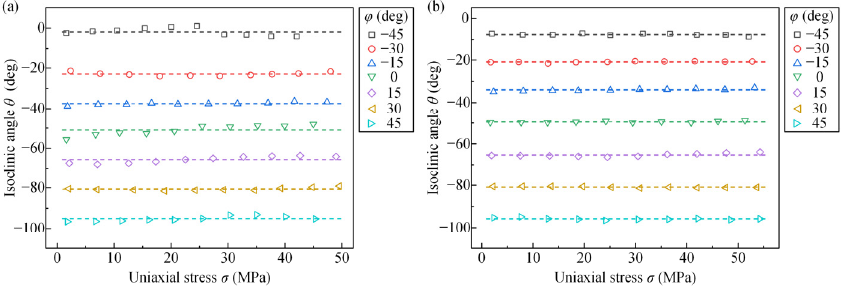
Figure 6. The relation between the isoclinic angle and uniaxial stress of PET films with different stretching angles in ( a ) transmission photoelastic experiments and ( b ) reflection photoelastic ex- periments.